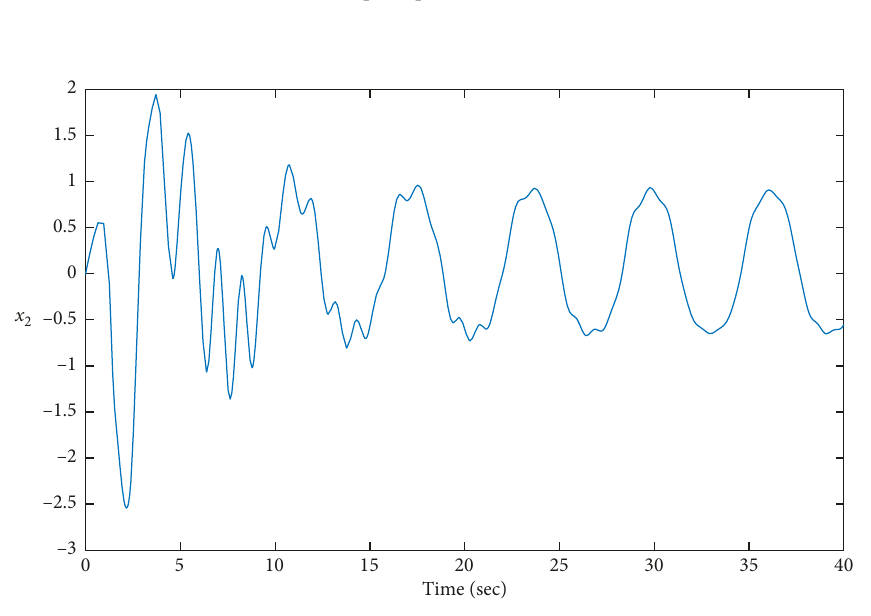
Figure 4: Adaptive parameters 􏽢 W